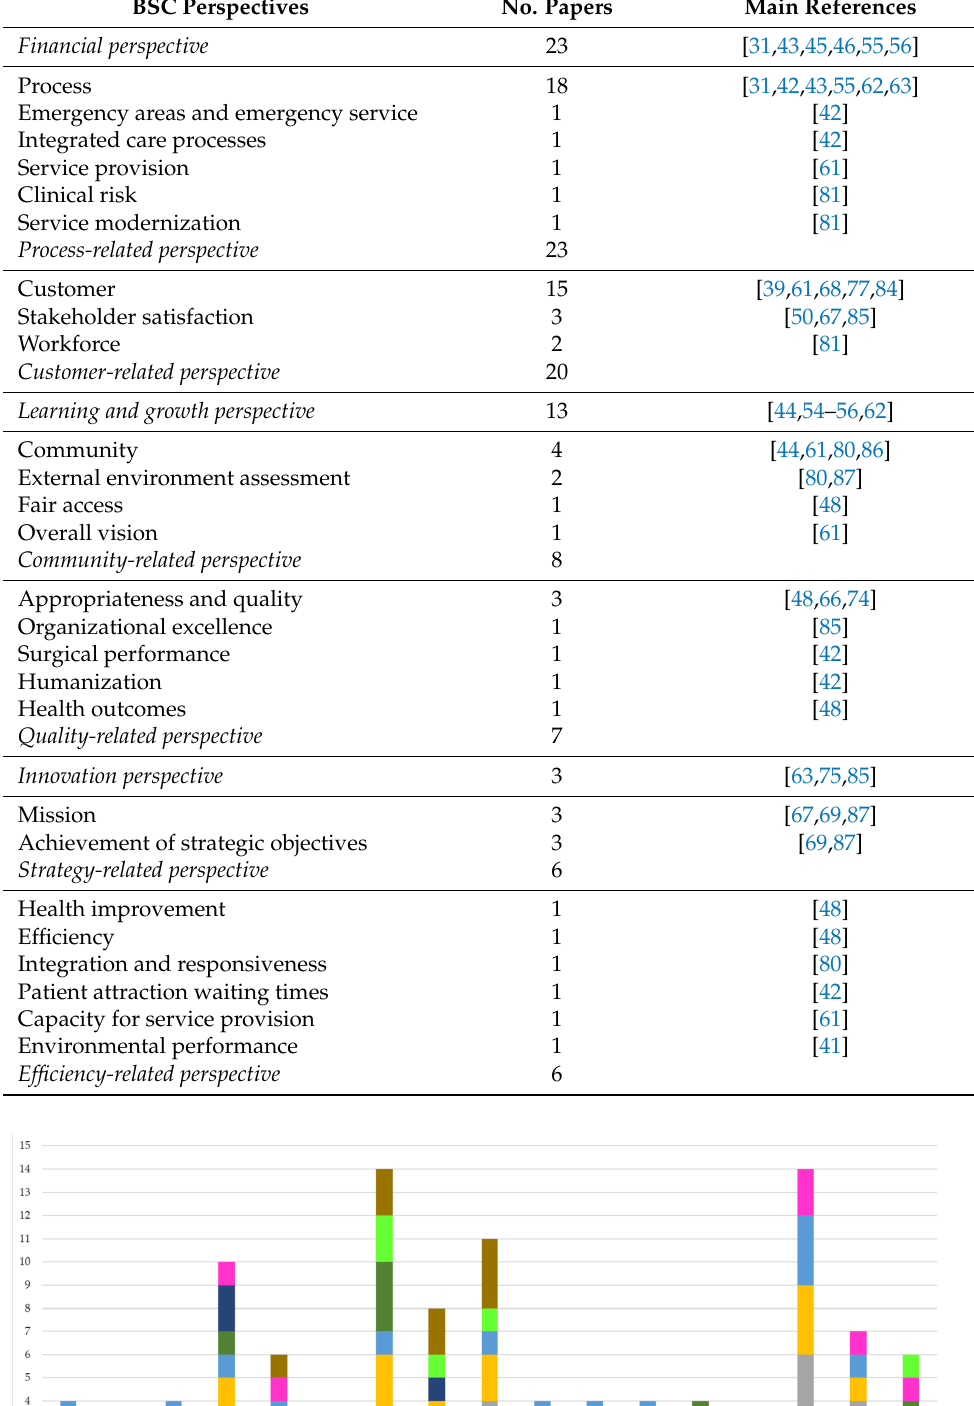
Table 7. Perspective identified after the analysis.